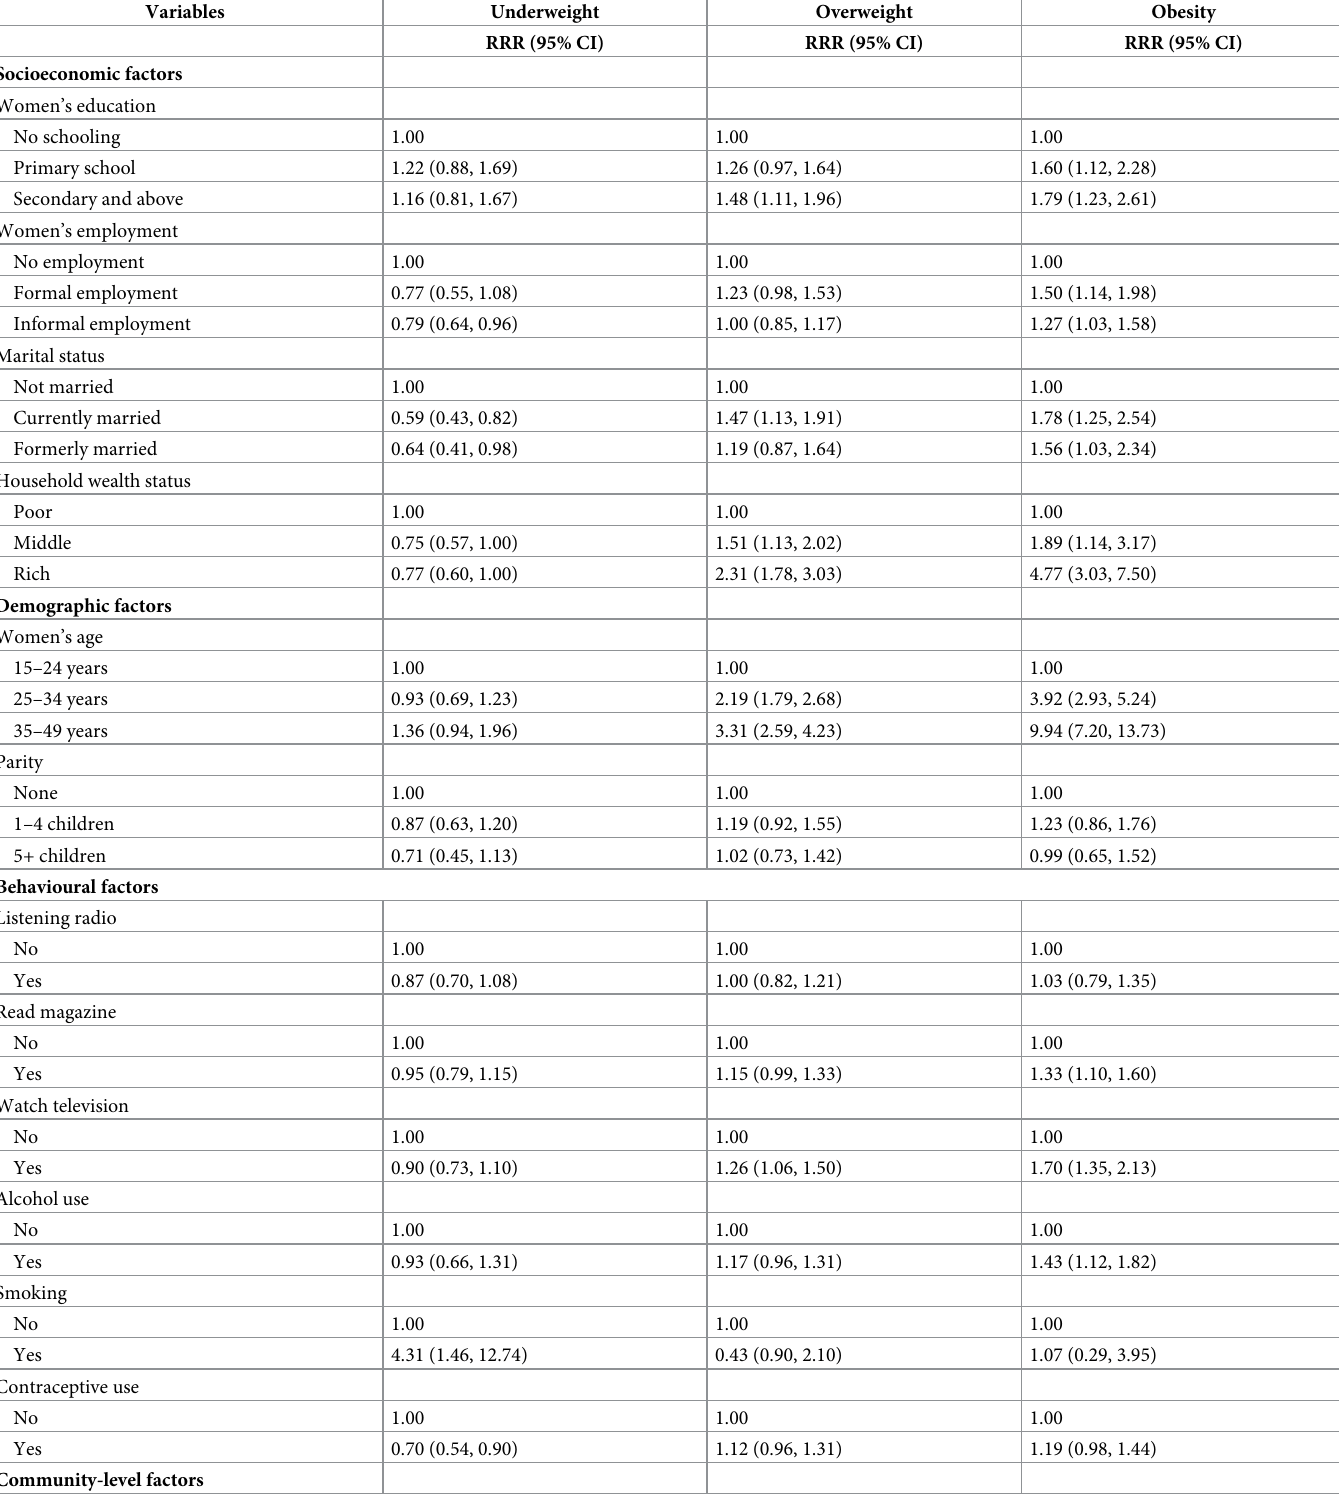
Table 2. Factors associated with underweight, overweight and obesity in reproductive age Tanzanian women, TDHS